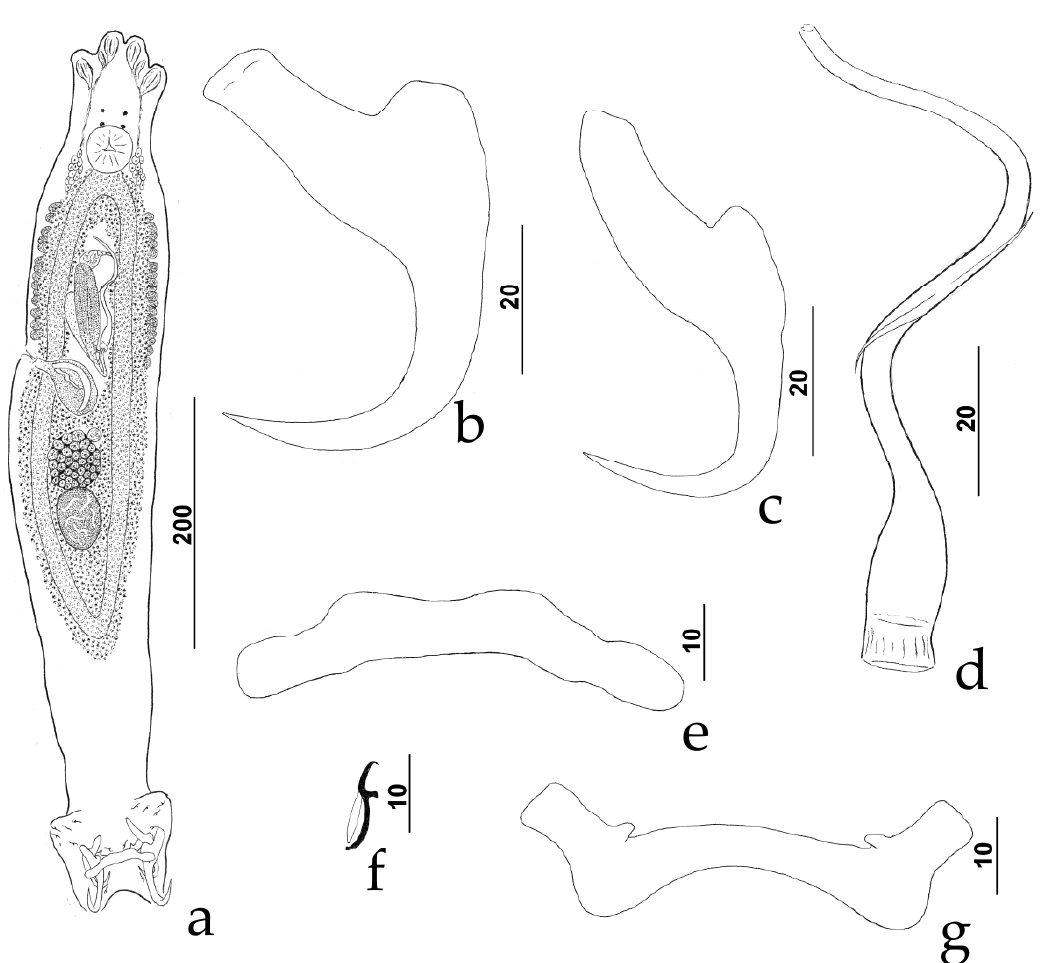
Figure 3. Platycephalotrema mastix n. sp. ( a ). Whole mount (composite, ventral view); ( b ). ventral anchor; ( c ). dorsal anchor; ( d ). male copulatory organ (ventral view); ( e ). ventral bar; ( f ). hook; ( g ). dorsal